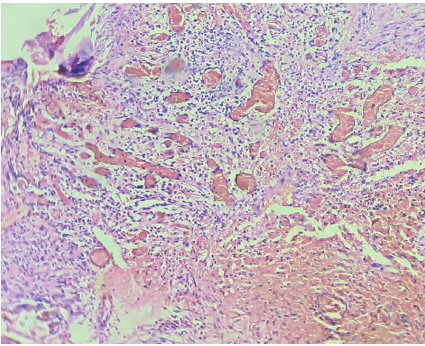
Figure 5: Fibrous connective tissue showing numerous thin walled vascular spaces (H&E